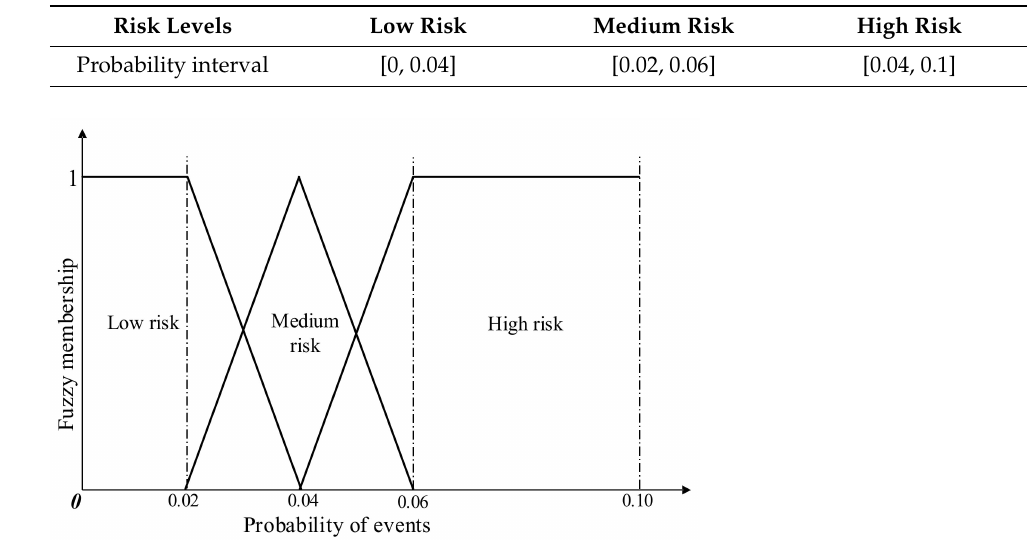
Figure 4. A mapping example between risk level and